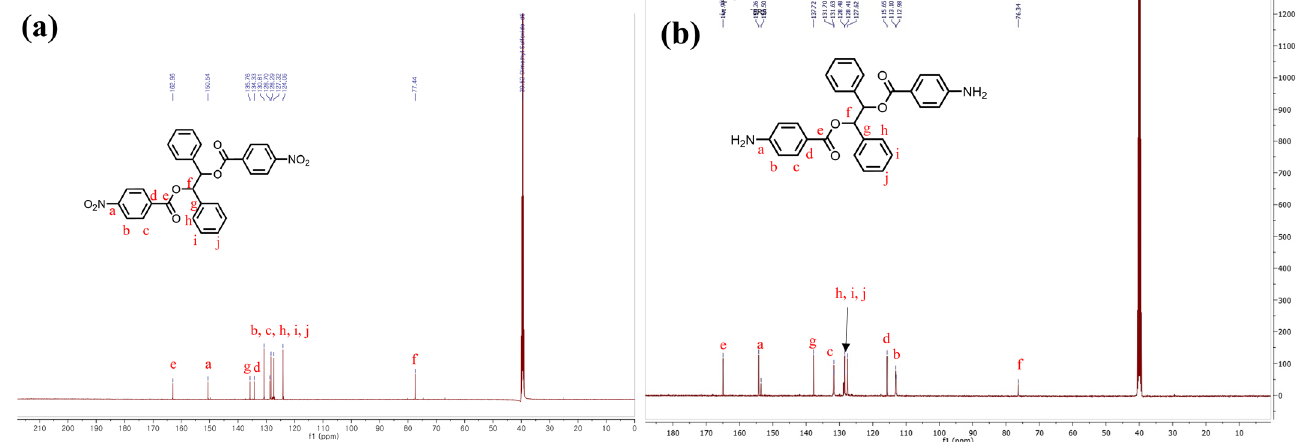
Figure 3. 13 C-NMR spectra of ( a ) 1,2-DPEDBN and ( b ) 1,2-DPEDBA. Furthermore, the functional groups of 1,2-DPEDBN and 1,2-DPEDBA were investi- gated by FT-IR spectroscopy. In Figure 4, for the 1,2-DPEDBN spectrum, the distinctive absorption bands at approximately 1528 and 1353 cm − 1 were due to asymmetric and symmetric vibrations of the nitro groups (N=O), respectively. Additionally, the absorption bands at approximately 1731, 1267, and 1099 cm − 1 were due to the vibration of the ester groups (C=O, C-O) [42]. After the hydrogenation reaction, distinctive absorption bands at approximately 3478, 3358, 1622, 1174, and 702 cm − 1 newly appeared due to the primary amine groups (N-H,